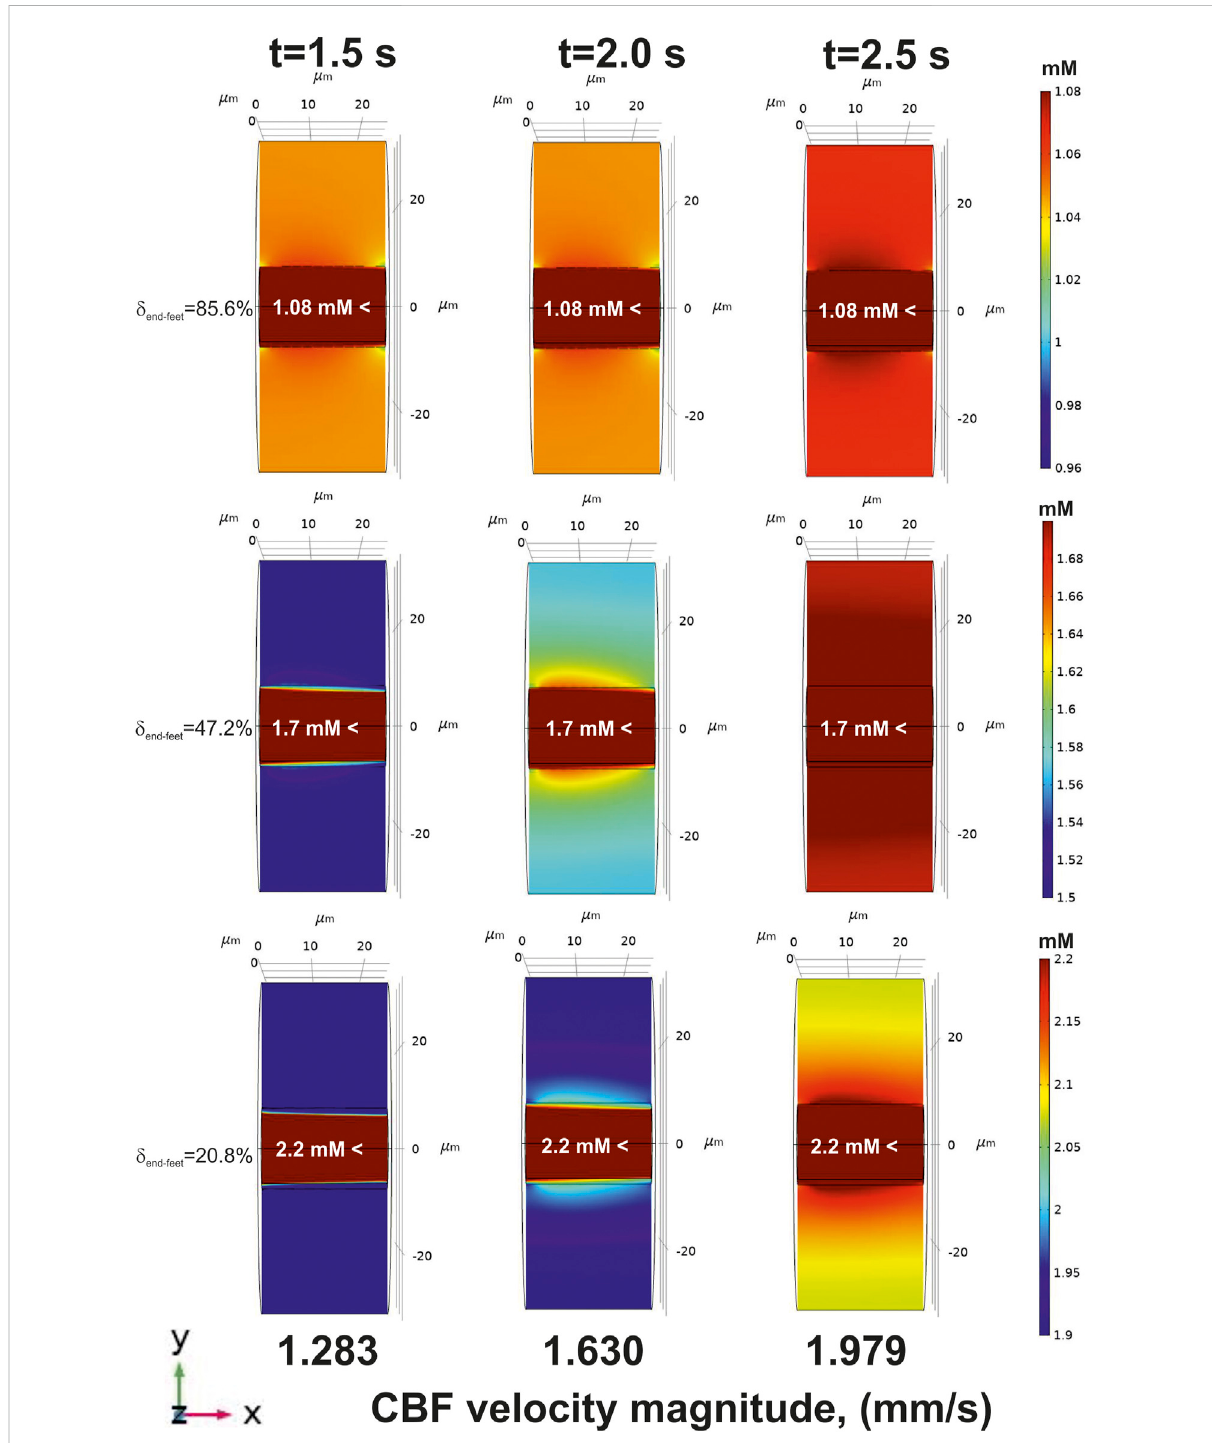
FIGURE 7 The glucose gradients near a blood capillary surface after CBF increase [application of f inc shift ( t ) ]. All designations are the same as in Figure